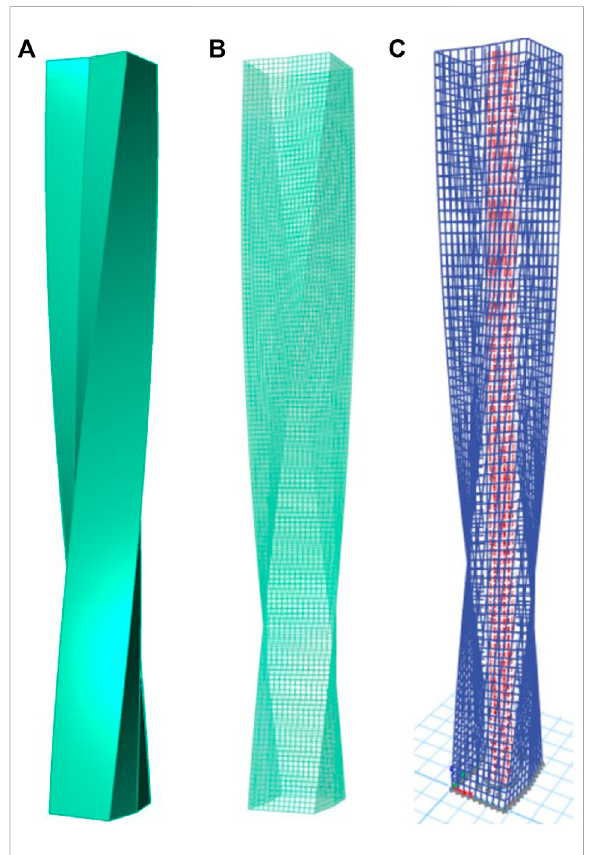
FIGURE 4 Parametric models: (A) Bluff, (B) detailed and (C) structural.